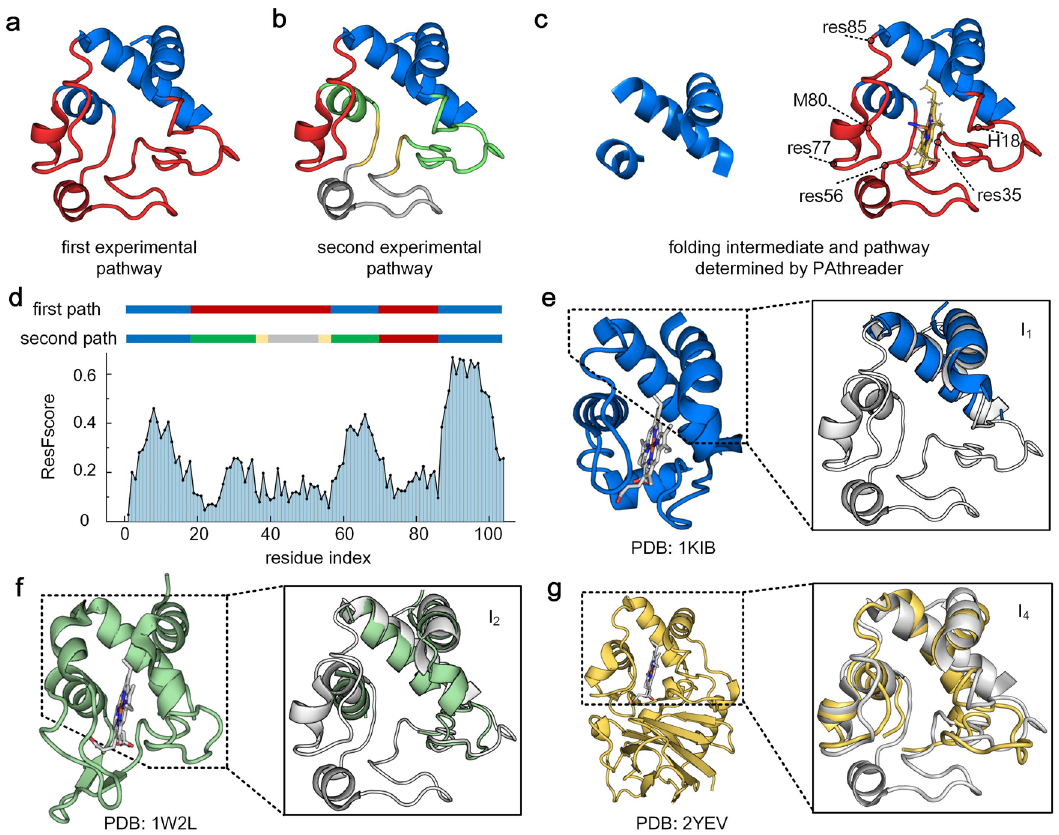
Fig. 5 Folding pathway of horse heart cytochrome c (PDB ID: 1I5T). a The fi rst experimental pathway. The blue region is fi rst folded and is followed by the red region. b The second experimental pathway. Blue is folded fi rst, followed by green, yellow, red and then grey. It contains 4 intermediates, I (blue + green), I 3 (blue + green + yellow) and I 4 (blue + green + yellow + red). c Intermediate and folding pathways predicted by PAthreader, the blue region is fi rst folded and is followed by the red region. d Two different experimental paths and the ResFscore distribution of residues identi fi ed by PAthreader. e – g Template structures from 1KIB, 1W2L and 2YEV. The solid line box is the partial superposition of templates and the structure of horse heart cytochrome c (grey), which correspond to intermediates of the second experimental pathway.